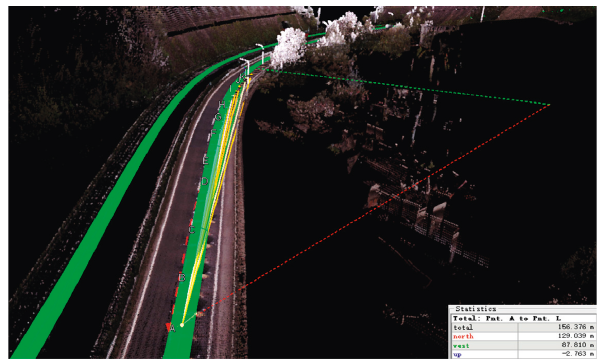
Figure 6: Measurement of 3D ASD in point cloud.